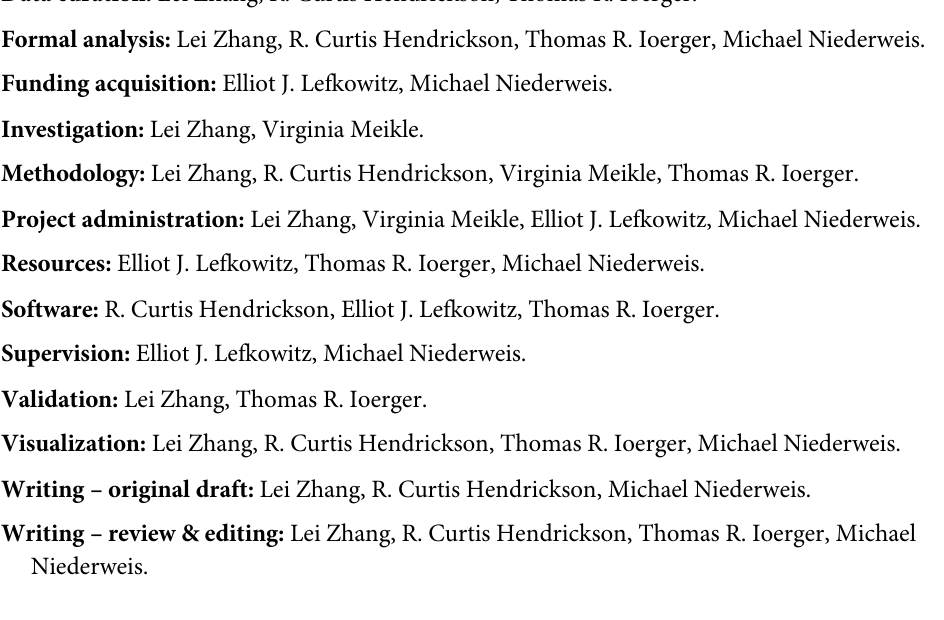
S6 Table. ANOVA analysis and functional categorization of genes involved in iron utiliza- tion by Mtb. S7 Table. Resampling analysis of genes involved in iron utilization by Mtb. S8 Table. Hidden Markov Model analysis of genes involved in iron utilization by Mtb. S9 Table. Shared genetic determinants of iron utilization by